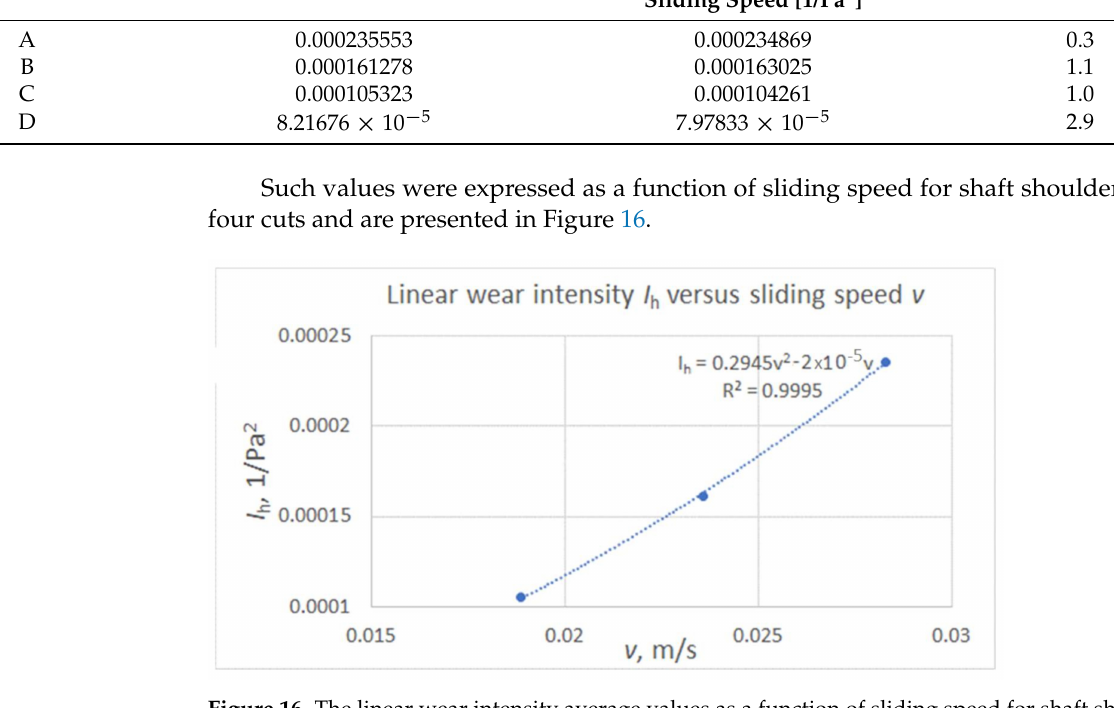
Figure 16. The linear wear intensity average values as a function of sliding speed for shaft shoulders with four